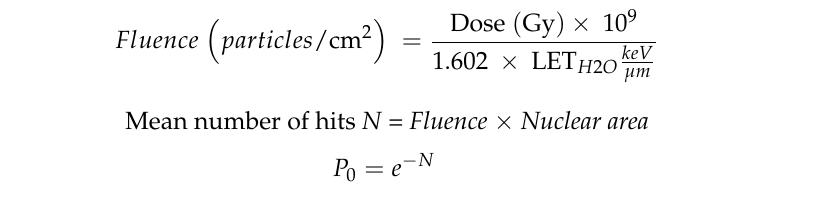
Table 1. Mean number of hits per nucleus after irradiation with Carbon (C)-ions. Calculation of mean number of hits per nucleus (nuclear area of human microvascular endothelial cells (HMVEC) = 200 µ m 2 ) and number of cells with 0 hit after irradiation with C-ions (linear energy transfer (LET H2O ) = 323 keV/ µ m) according to the Poisson distribution. Fluence Mean Number of Cells with 0 Hit P 0 Dose (Gy) (Particles/cm 2 ) Hits/Nucleus N 0.1 1.92 × 10 5